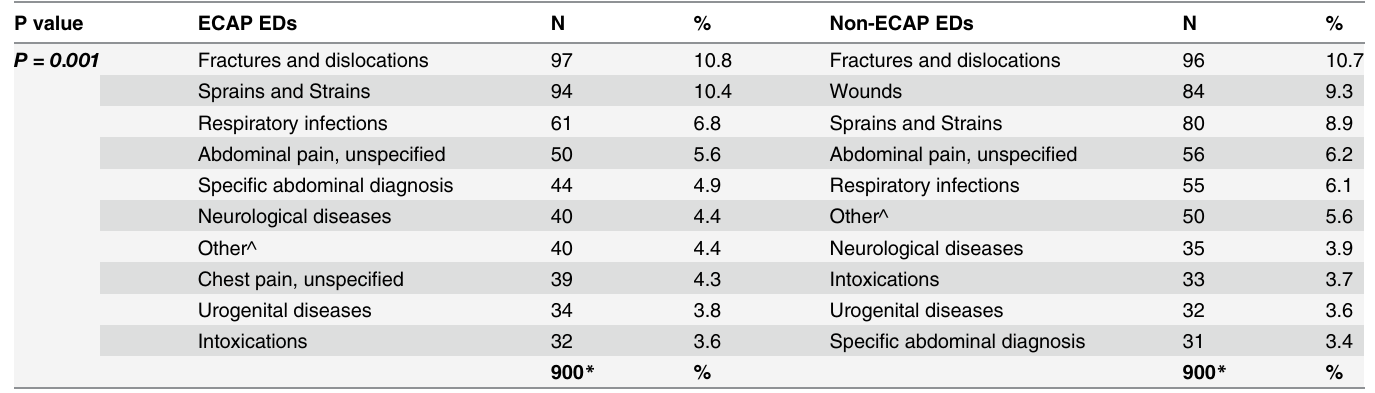
Table 6. Top ten of grouped ICD 10 codes #